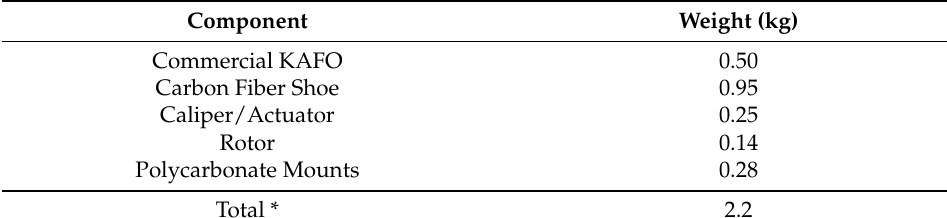
Table 2. Weight of Assembly Components.